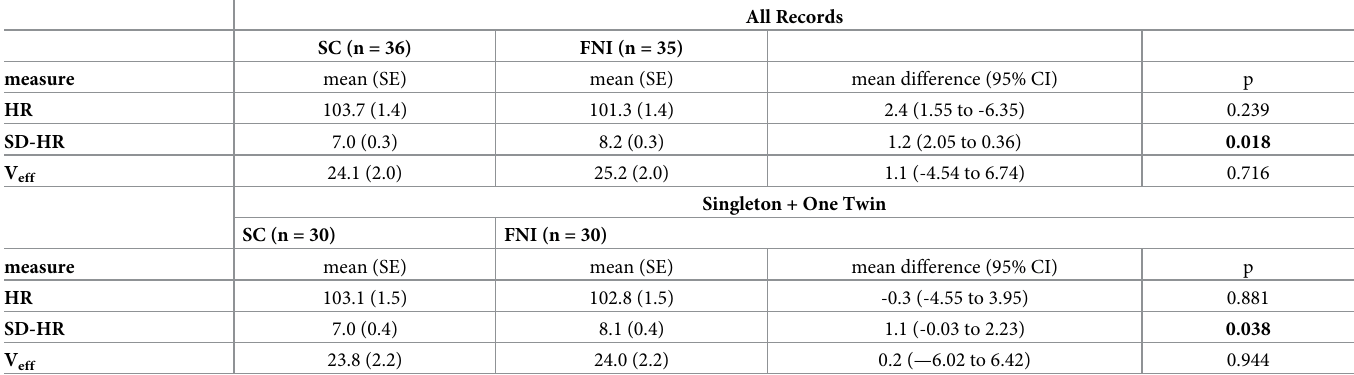
Values for HR and SD-HR are based on averages across multiple 30 sec epochs. Values for V eff are derived from 10-second epochs and reflect the slopes of the relationship between heart period (i.e., mean of the R-to-R intervals) and RSA, one value for each subject. Two sets of data are shown; the top set are values for all children, the bottom set (are values from singletons and only one twin. These means and SE are after adjustment for covariates (gestational age at birth, birth weight, age in months at the time of assessment (adjusted for weeks premature), sex, and twin status (Y/N). Abbreviations: HR, heart rate; NS, not significant; SD-HR, standard deviation of HR, V eff , vagal efficiency.